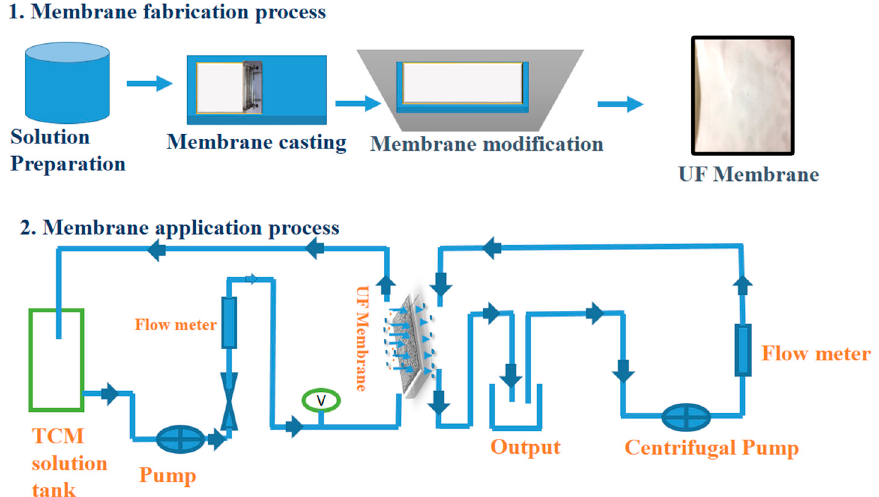
Figure 2. Flow chart membrane fabrication method ( 1 ) and application process ( 2 ) .